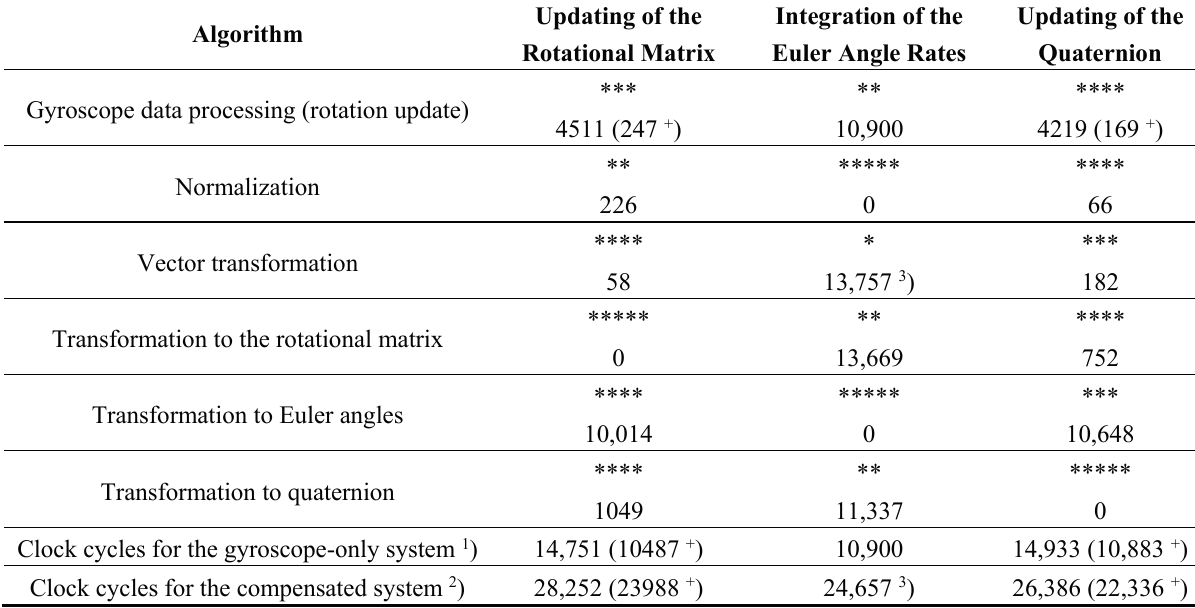
Table 2. Comparison of methods in terms of 32-bit UC3C processor clock cycles. Algorithm